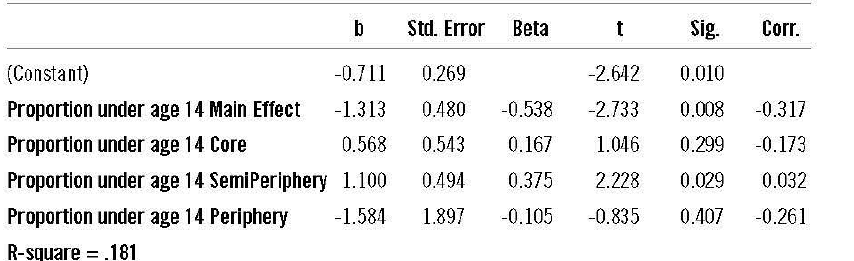
Table 3b - Contextual 4-Dumrny Model for Proportion Under Age 14 b